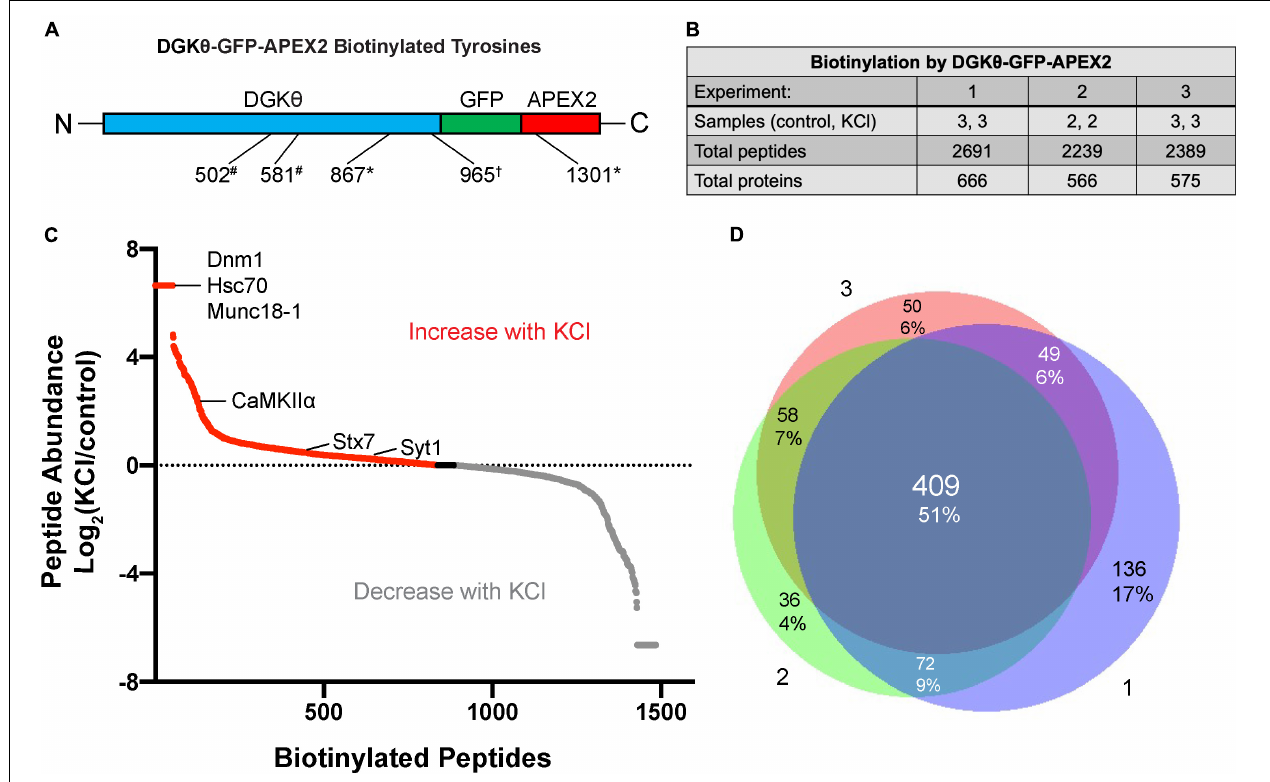
FIGURE 2 | Differential labeling of synaptic proteins by DGK θ -GFP-APEX2 with KCl. (A) Biotinylated tyrosine residues within DGK θ -GFP-APEX2, corresponding to peptides identified in one (*), two (#), or three ( † ) experiments. (B) Mass spectrometry experiments 1 and 3 consisted of three KCl-depolarized samples and three control samples, while experiment 2 consisted of two of each. Each sample contains ∼ 50 e 6 cells. The three experiments produced similar numbers of total biotinylated peptides and their corresponding proteins. (C) The differential labeling of peptides with KCl is illustrated for mass spectrometry experiment 2. All biotinylated peptides identified are graphed by their log 2 (peptide abundance). Peptide abundance is calculated as (relative abundance in KCl-depolarized samples)/(relative abundance in control samples). (D) Of the total number of peptides identified from our three mass spectrometry experiments, 51% were found in all three experiments, 22% were found in two of the three experiments, and 27% were found in only one